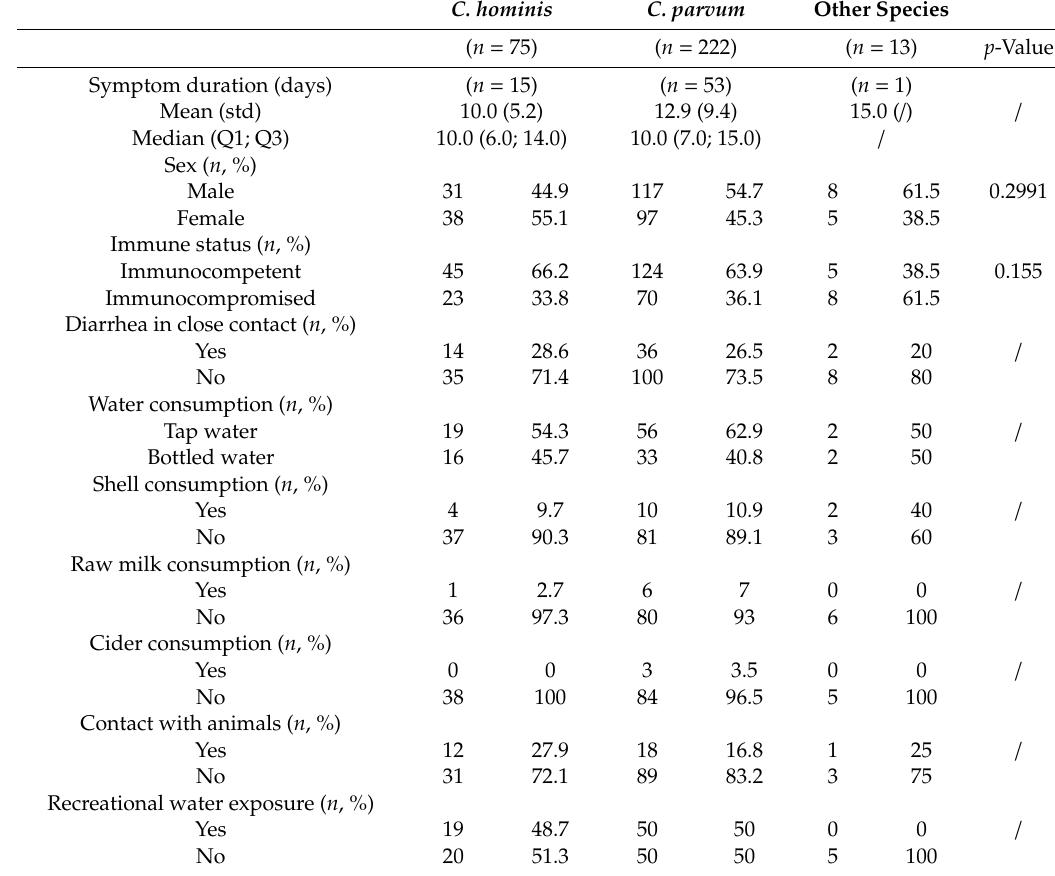
Figure 4. Distribution of GP60 subtypes of C. hominis / C. parvum species among reported cases in France from 2017 to 2019. Table 6. Associations between Cryptosporidium species and symptoms, gender, immune status, and risk factors of notified